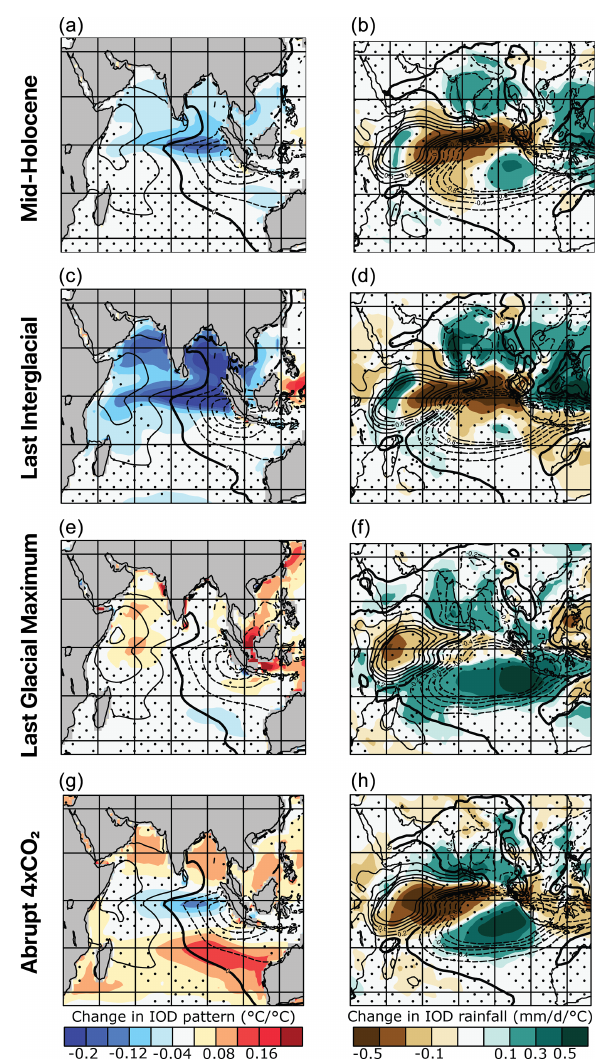
Figure 5. Ensemble mean change in SST and rainfall patterns of the Indian Ocean Dipole. Each row represents the ensemble mean difference from the piControl simulations and a different experiment, with the midHolocene changes in SST (a) and rain- fall (b) , the lig127k changes in SST (c) and rainfall (d) , the LGM changes in SST (e) and rainfall (f) , and the abrupt4xCO2 changes in SST (g) and rainfall (h) patterns. The patterns within each simula- tion are first computed through regressing monthly anomalies onto the Dipole Mode Index; then each model’s changes in those patterns are averaged across the ensemble (see Sect. 2.3). Stippling indicates where the ensemble is not consistent in the direction of change (i.e. less than two-thirds agree on it). The overlaid contours show the ensemble mean pattern in the piControl simulations, with dashed contours indicating negative numbers. As the models contributing to each experiment change, so does the precise pattern of piControl